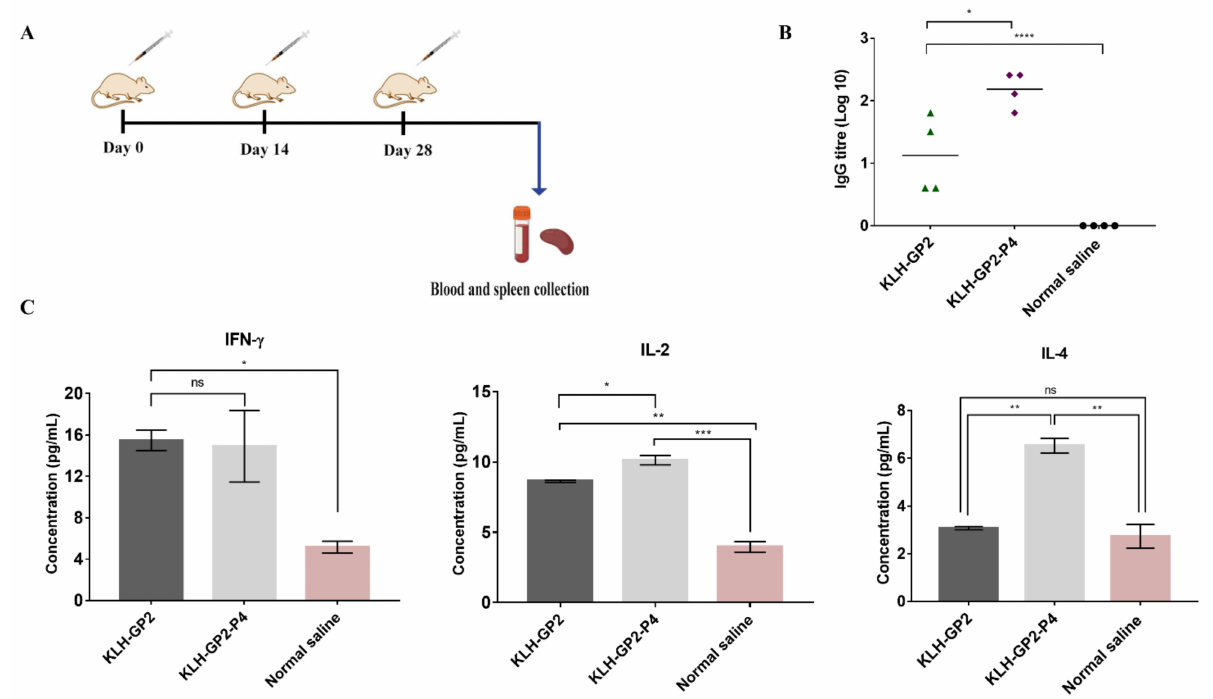
Figure 2. ( A ) The schematic protocol of BALB/c mice immunization with peptide-based vaccine candidates. Sera and spleen of immunized mice were collected two weeks after the final vaccination. ( B ) HER2/neu-specific IgG antibody titers in serum. Each point in the figure represents an individual mouse ( n = 4), and the mean antibody titers are represented as a bar. ( C ) Level of splenocyte cytokines response prior to final immunization. The data represent mean concentrations ± SEM. Statistical analysis was performed using one-way ANOVA followed by Tukey’s multiple comparison test (ns, p > 0.05; * p < 0.05; ** p < 0.01; *** p < 0.001, and **** p <